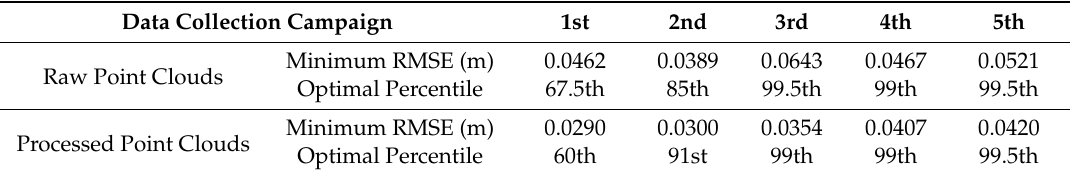
Table 2. Optimal root-mean-square error (RMSE) and percentile of raw and processed point clouds at each data collection campaign.